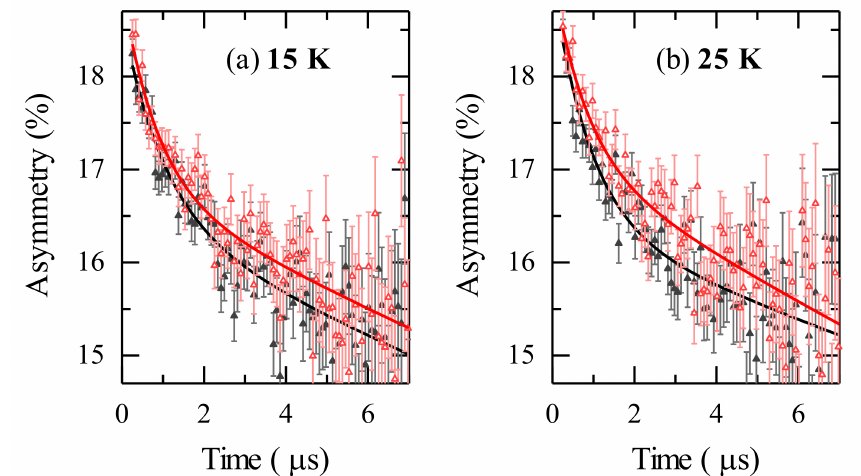
Figure 3. Different asymmetry data for regio-regular P3HT–ZnO nanoparticles for 10 mT with ( (cid:52) ) and without ( (cid:78) ) light irradiation at temperatures of ( a ) 15 K and ( b ) 25 K.